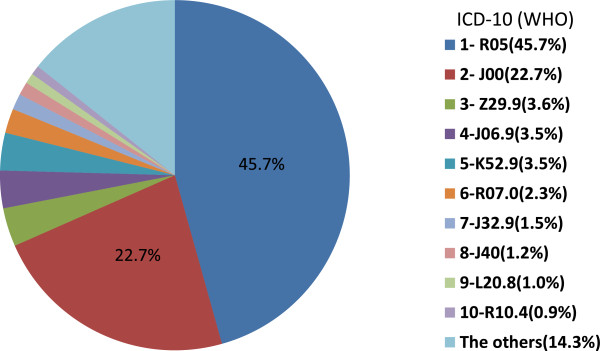
Indications of herbal medicinal products (N = 1,152). Data source: German National Health Interview and Examination Survey for Children and Adolescents (KiGGS) 2003–2006. ICD-10, WHO: R05: Cough; J00: Acute nasopharyngitis (common cold); Z29.9: Prophylactic measure; J06.9: Acute upper respiratory infection; K52.9: Noninfective gastroenteritis and colitis; R07.0: Pain in throat and chest; J32.9: Chronic sinusitis; J40: Bronchitis, not specified as acute or chronic; L20.8: other atopic dermatitis; R10.4: other and unspecified abdominal pain.